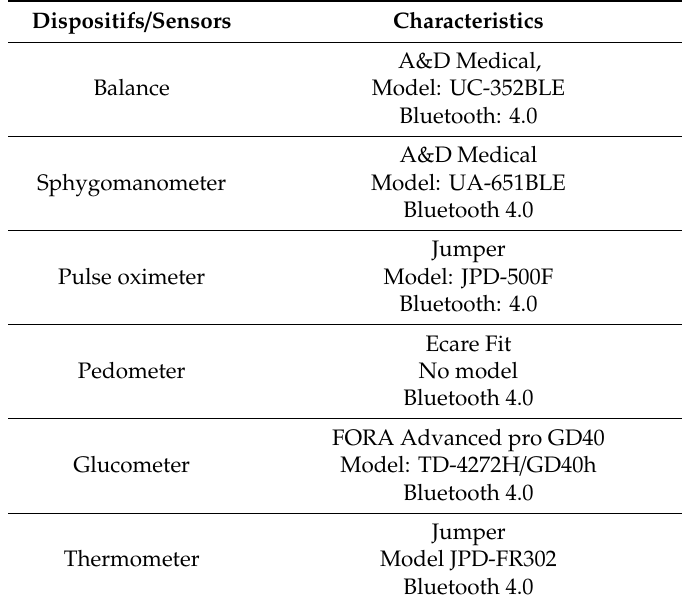
Table 4. Technical characteristics of the MyPredi TM platform sensors